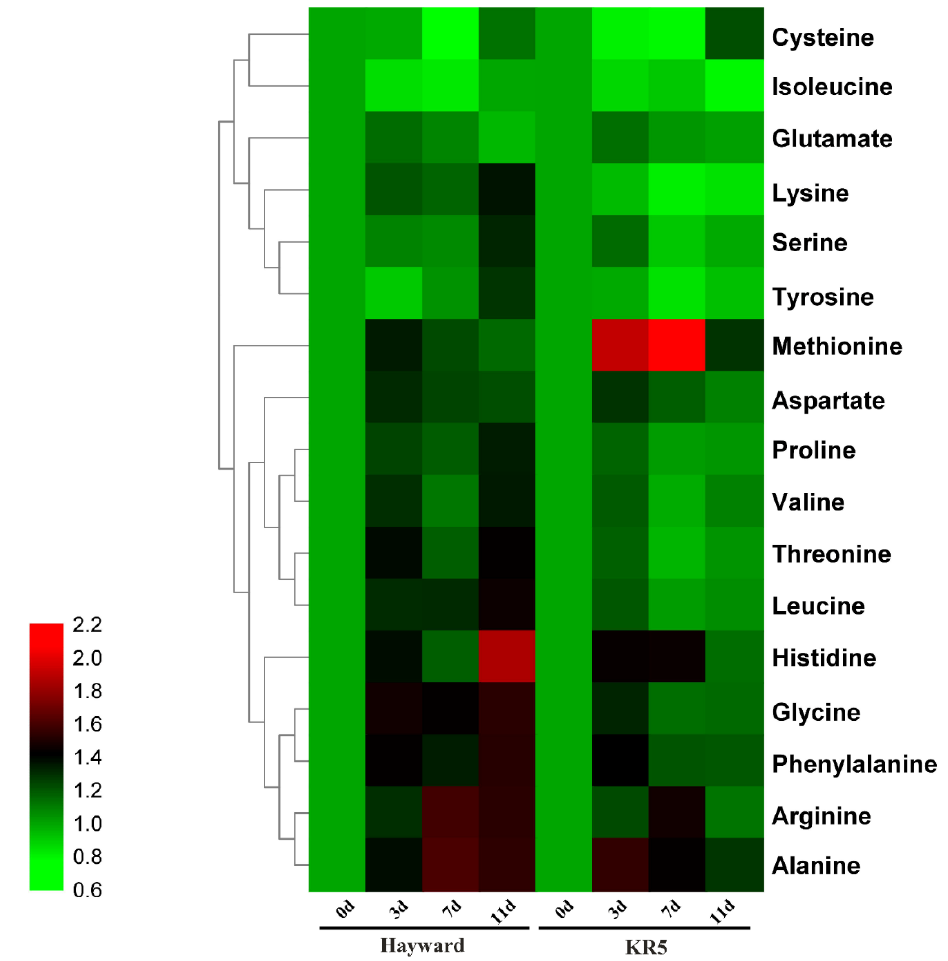
Figure 8. Change trends of individual amino acids in ‘Hayward’ and KR5 roots under waterlogging stress. For each amino acid, the value is computed by taking the ratio of the content of waterlogged plants and that of control plants.